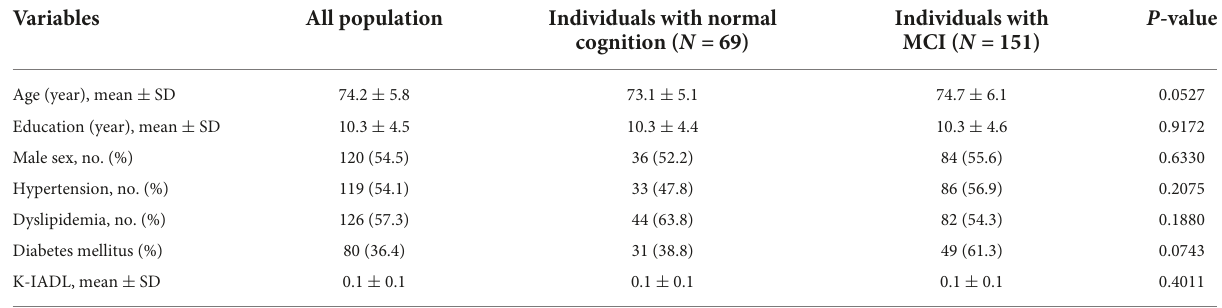
TABLE 1 Characteristics of study population according to cognitive impairment status. Variables All population Individuals with normal